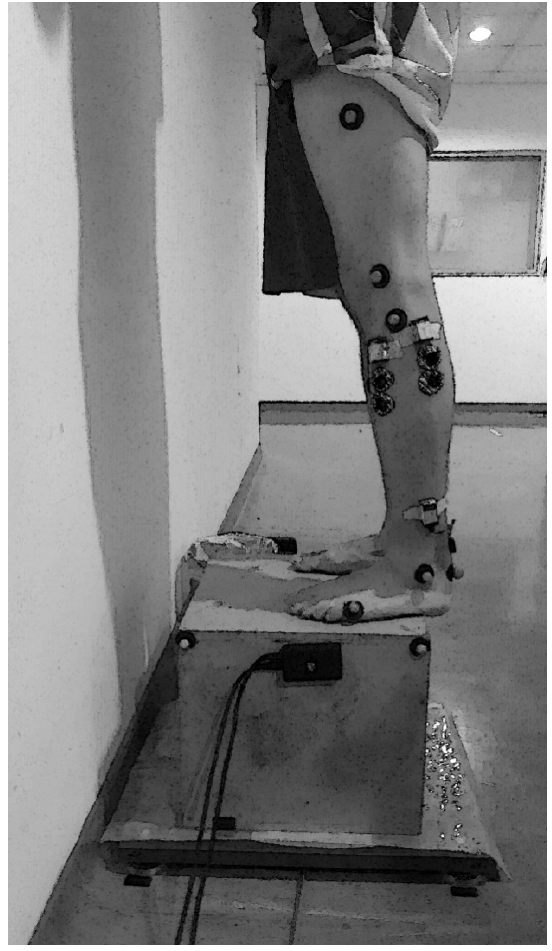
Figure 1. The experimental setting comprising the electromyographic (EMG) recording electrodes, marker set, and force plate used for motion analysis.